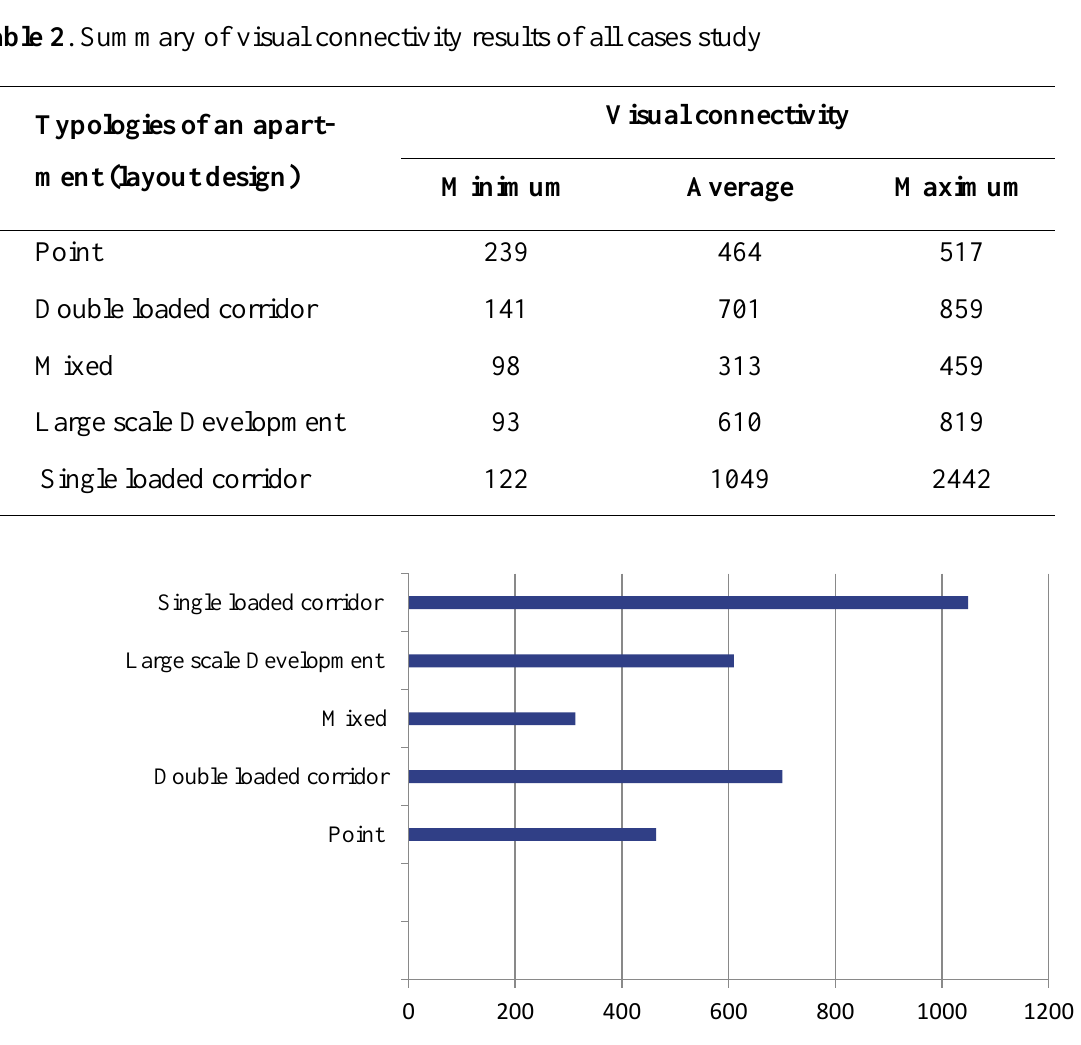
Figure 2. Comparison of functionality parameters average among the case